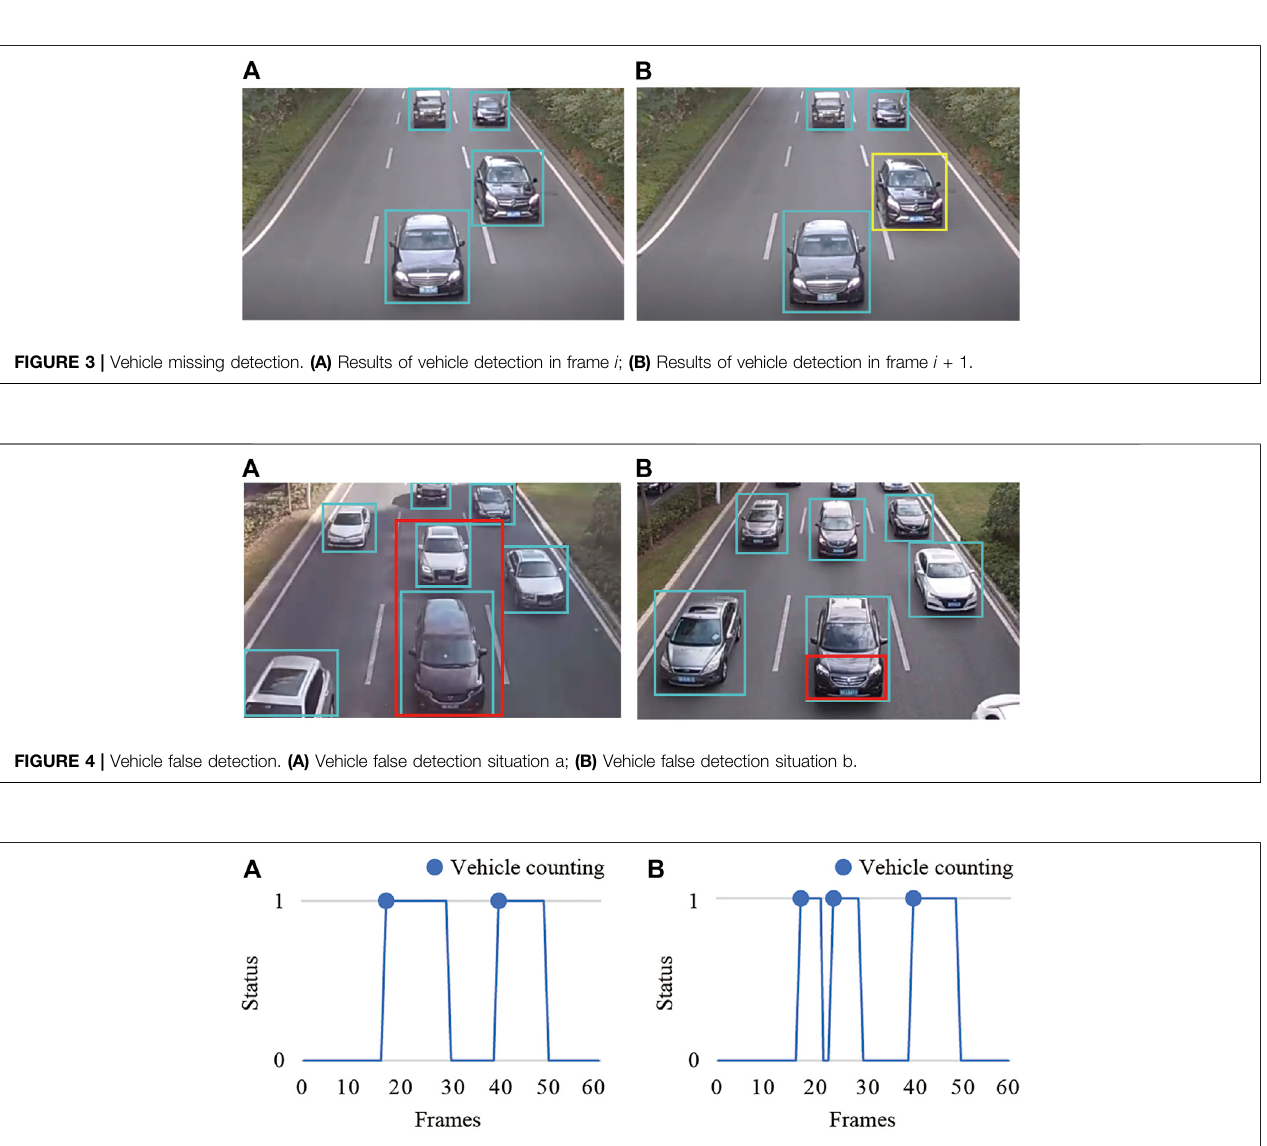
FIGURE 5 | Incorrect vehicle counting caused by vehicle missing detection. (A) Flow curve of correct counting; (B) Flow curve of incorrect counting.